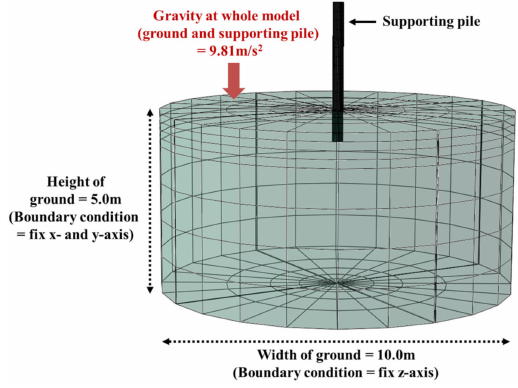
Figure 16. Modeling of